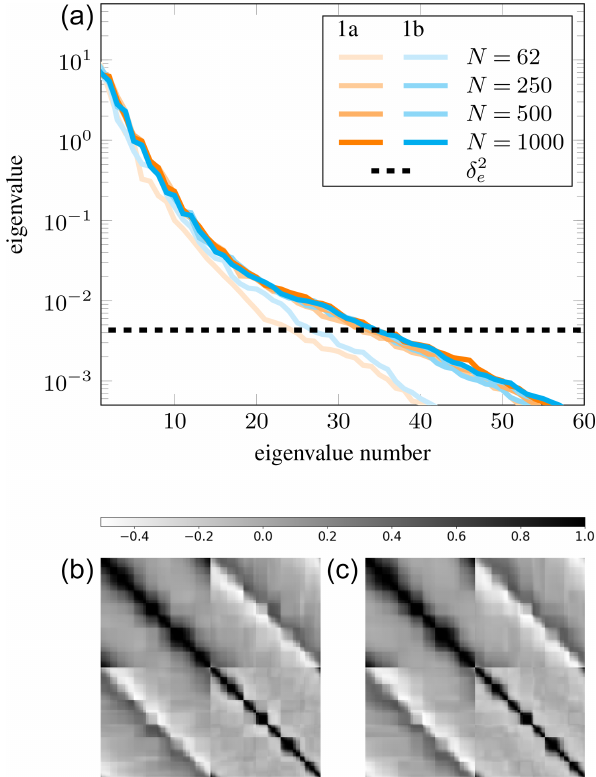
Figure 6. Convergence and (Pearson’s) correlation matrix of the ap- proximation errors for Example 1. (a) Spectrum of (cid:48) ε for various sample sizes, N , for Example 1a (orange) and Example 1b (cyan), along with the noise variance, δ 2 e . (b, c) (Pearson’s) correlation ma- trix of the approximation errors for Example 1a (b) and 1b (c)